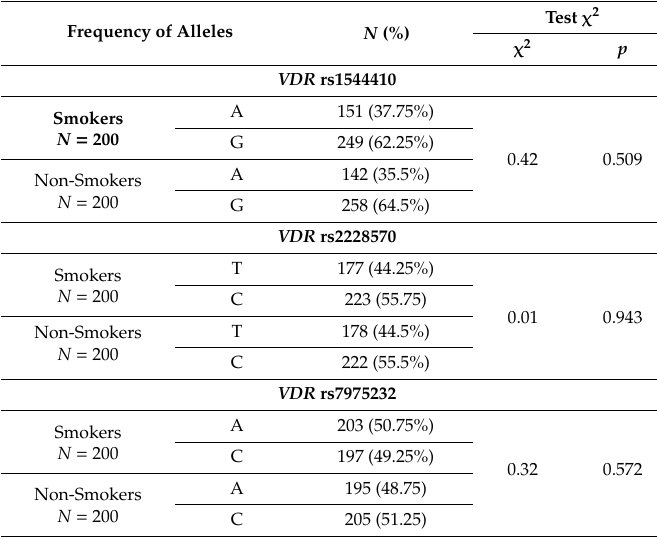
Table 3. Frequency of alleles of the of the VDR rs1544410, VDR rs2228570, VDR rs7975232 genes polymorphisms in smokers and in non-smokers. Frequency of Alleles N